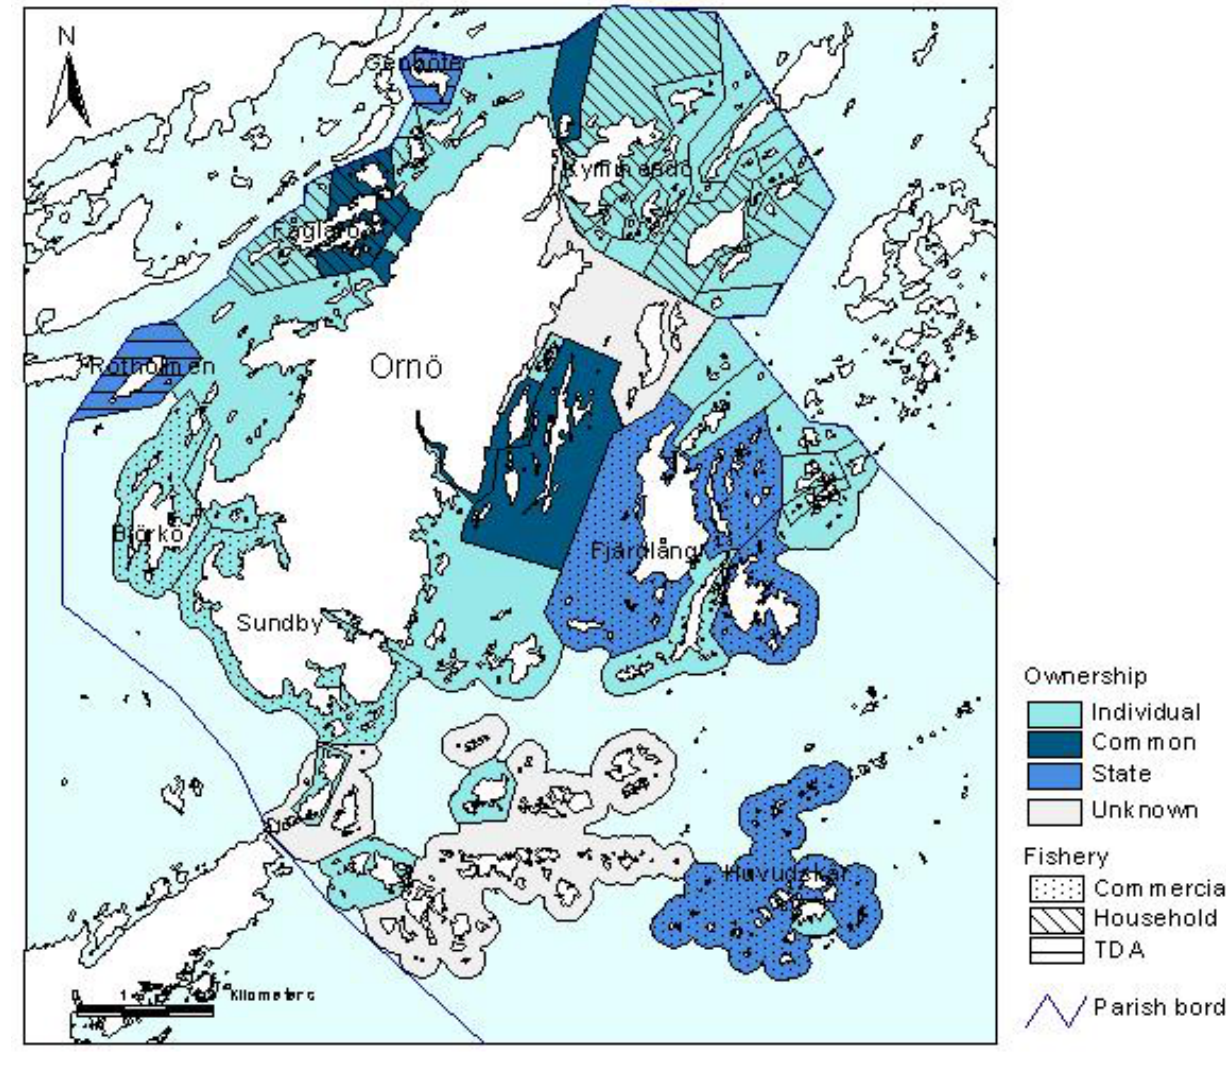
Fig. 2 . Spatial distributions of ownership and fishery categories in Ornö